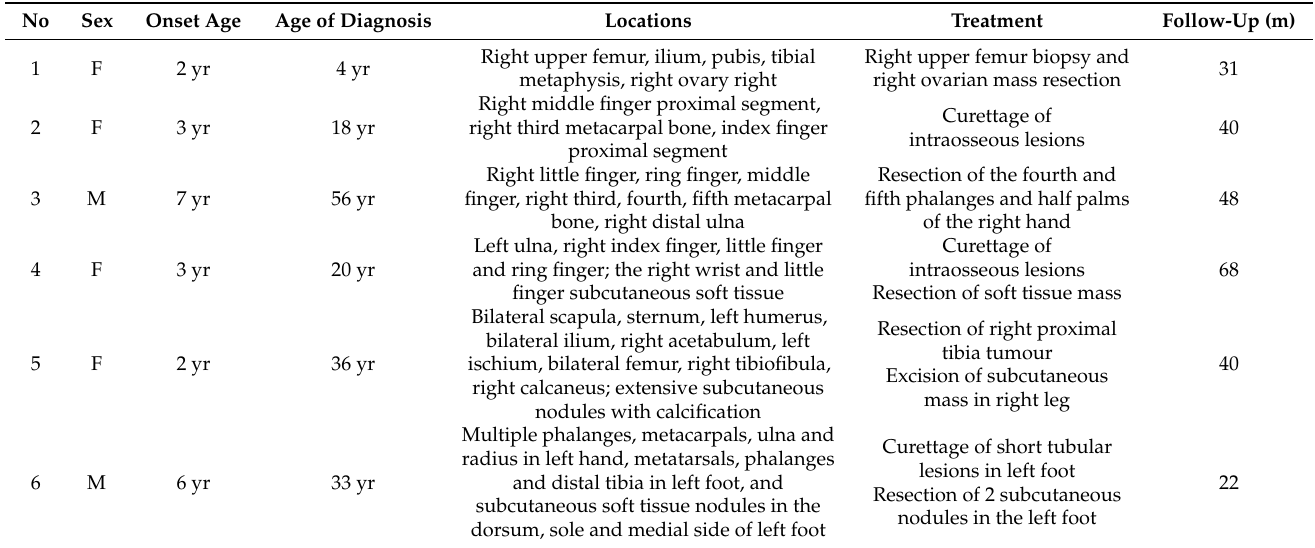
Table 1. Clinicopathological